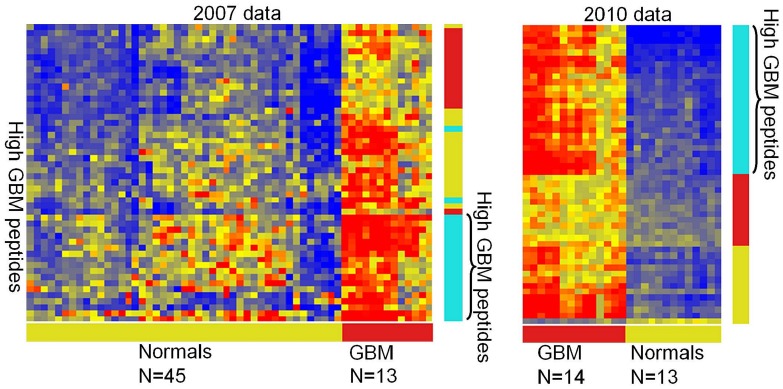
Glioblastoma training and test data.The heatmap on the left shows 50 peptides that differentiated glioblastoma patients from healthy persons obtained from 4 different geographical locations across the US (Fred Hutchison Institute, University of Washington, University of California Irvine, Arizona State University). These peptides were also used to classify different samples consisting of blinded patient and healthy sera obtained from the Barrow Neurological Institute 3 years later. The colored bars on the right indicate clusters that define groups of peptides. Although there are differences between the values obtained in 2007 and 2010, most of the high-binding peptides are very similar.